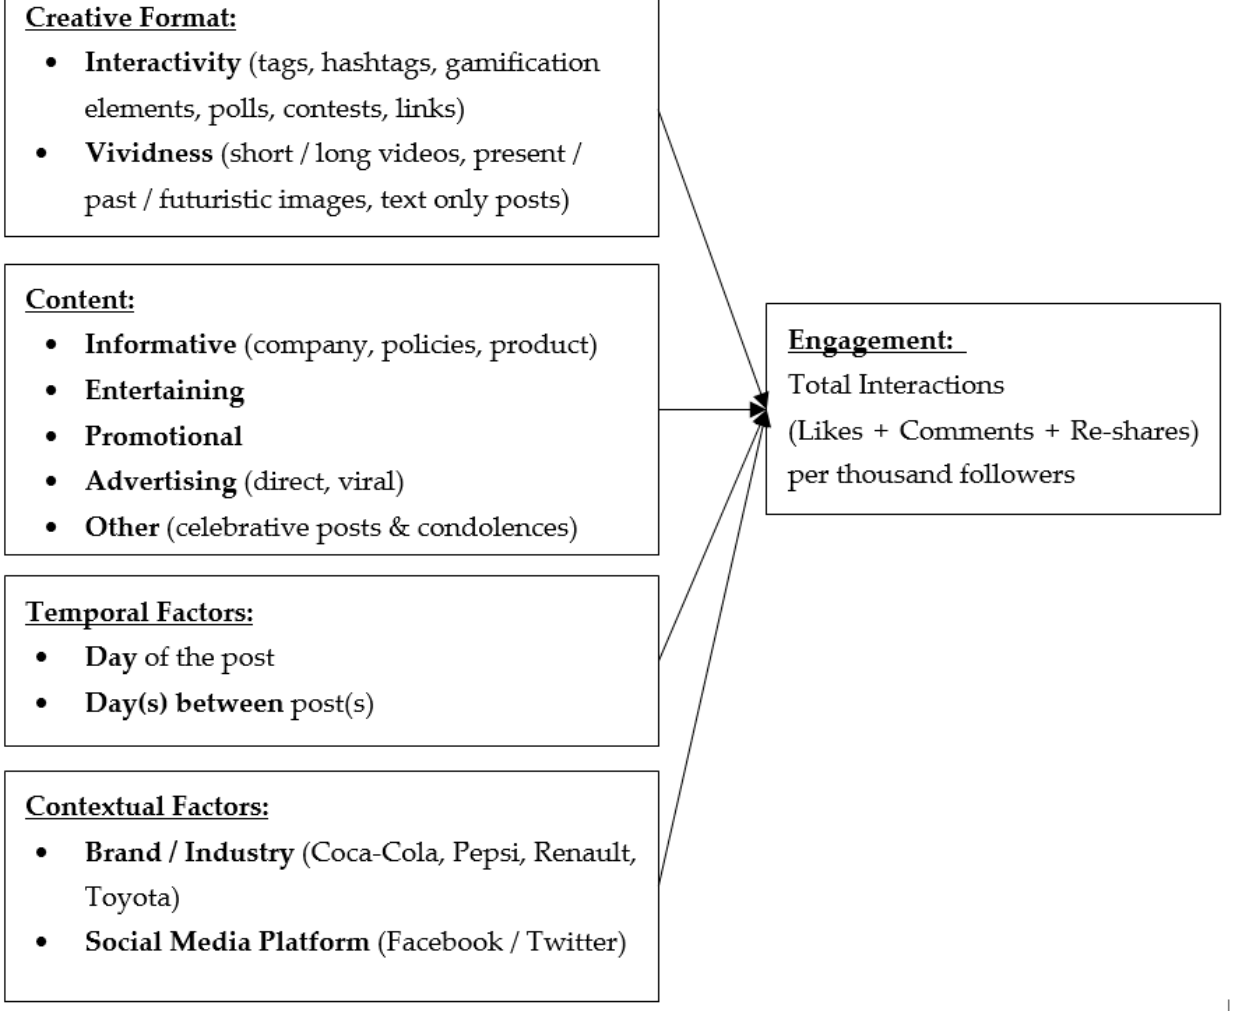
Figure 1. Research Figure 1. Research model.